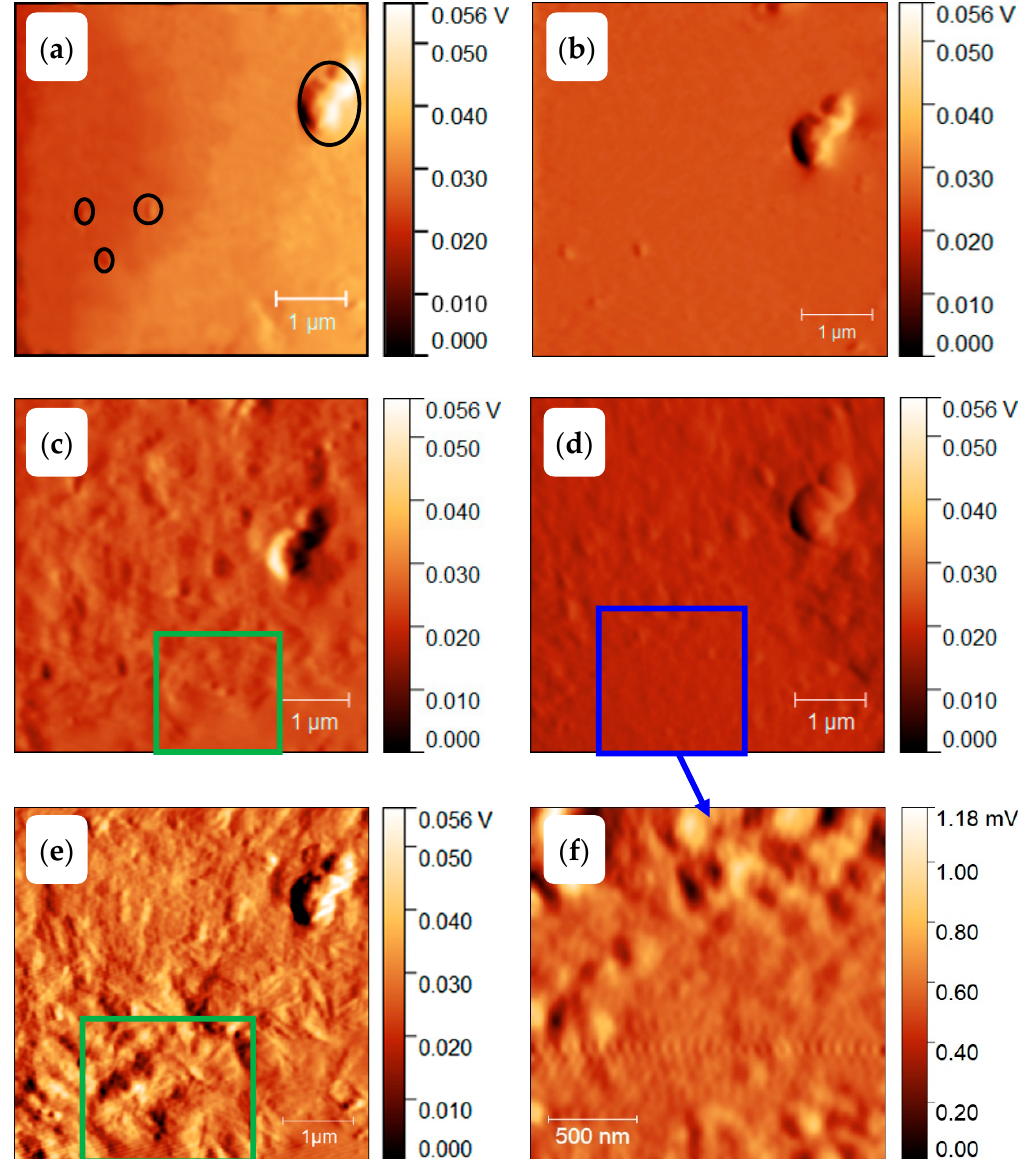
Figure 17. Zoomed-in AFM amplitude images from Figure 15. The images ( a – d ) are zoomed-in images of Figure 15b,d,f,h, respectively. The image ( e ) is the morphology that PBT melt-crystallized at 490 K for 2 s. The image ( f ) is a further zoom-in from image ( d ) showing a granular morphology with particle sizes of order 100